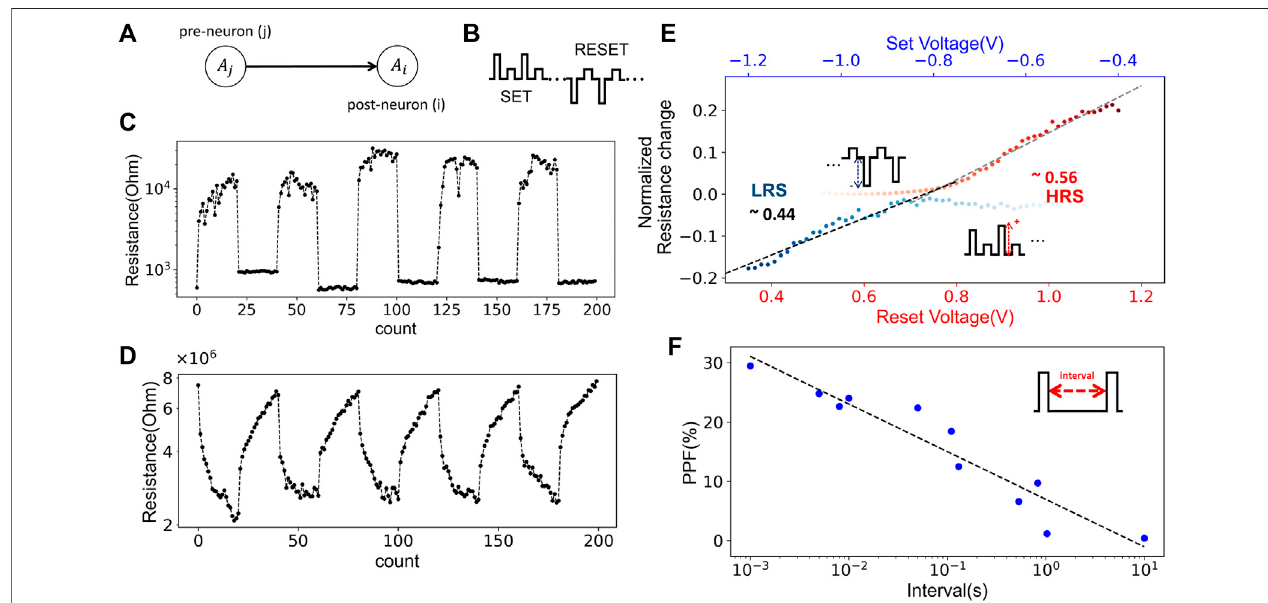
FIGURE 8 | (A) Sketch of synaptic plasticity process. (B) The waveform of voltage pulse trains; 20 SET pulses followed by 20 RESET pulses. A readout pulse followedeachswitchingpulse.Theresultingchangeinresistancestatesunderthevoltagetrainisshownin (C) fortypeF, (D) fortypeR.Thelinearityinresistancechange was improved in the type R. (E) The resistance as a function of the amplitude of SET/RESET voltages in type F. The amplitude of the applied voltage for a SET (RESET) was decreasing (increasing) to lead a next level in the resistance, and a readout voltage followed each switching voltage pulse. The multistate resistance was observedalongwiththesymmetricity betweenLRSandHRS. (F) PPFasafunctionofintervaltimebetweentwosequentswitchingvoltagepulsesintype R.Thedashed line presents a fi tted curve in the experimental data (blue). Increasing the time interval results in the weaker resistance change.